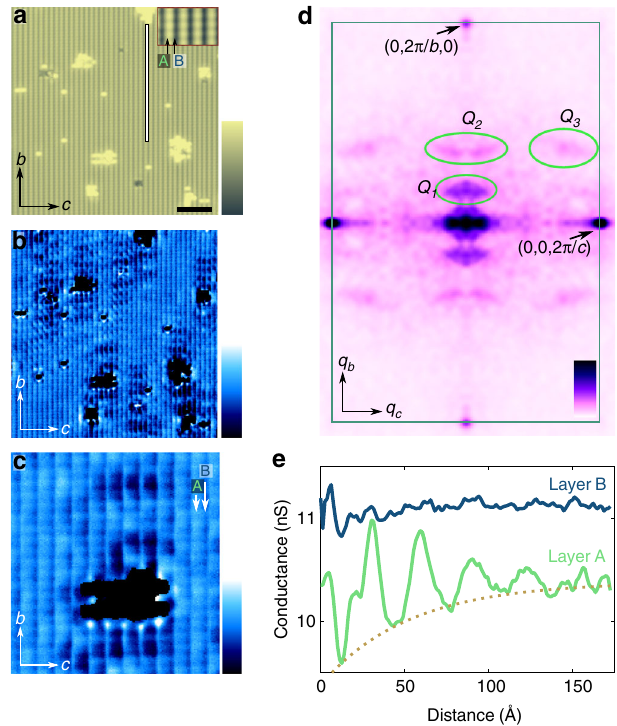
Fig. 3 Quasiparticle interference on the [100] surface. a Topographic image of surface S where the conductance map was acquired ( V bias = − 70 mV, I = 1 nA). Inset shows an enlarged topographic image with the setpoint position of layer A and B indicated. Scale bar: 50 Å; color scale: 5 Å. b Conductance map at E = − 70 meV energy showing quasiparticle standing waves around the atomic islands. The conductance of the islands is arti fi cially saturated for clarity. Color scale indicates the conductance and ranges from 9 to 12 nS. c Enlarged conductance map, which demonstrates the strongly one-dimensional scattering of the quasiparticles. Arrows indicate the position of layers A and B. Scale bar: 20 Å; color scale: conductance from 5 to 7 nS. d Symmetrized Fourier transform of the conductance maps shown in b . Green rectangle shows the border of the unit cell in reciprocal space. Color scale indicates the magnitude of the power spectral density. e The modulation of the LDOS along a line parallel to b -axis (shown as white line in a ) on top of layer B (blue) and top of layer A (green). Dark yellow curve shows the exponential decay envelope of the interference pattern obtained by fi tting the data with (cid:1) (cid:3) G d ð Þ ¼ G d þ φ e (cid:1) d = ξ QPI þ G d is the distance from the 2 π 0 sin mean , where λ QPI ¼ 52 : 4 island, λ QPI ¼ 31 Å is the wavelength of the quasiparticle signal, ξ QPI Å is the decay length, φ is the phase of the signal, and G mean is the